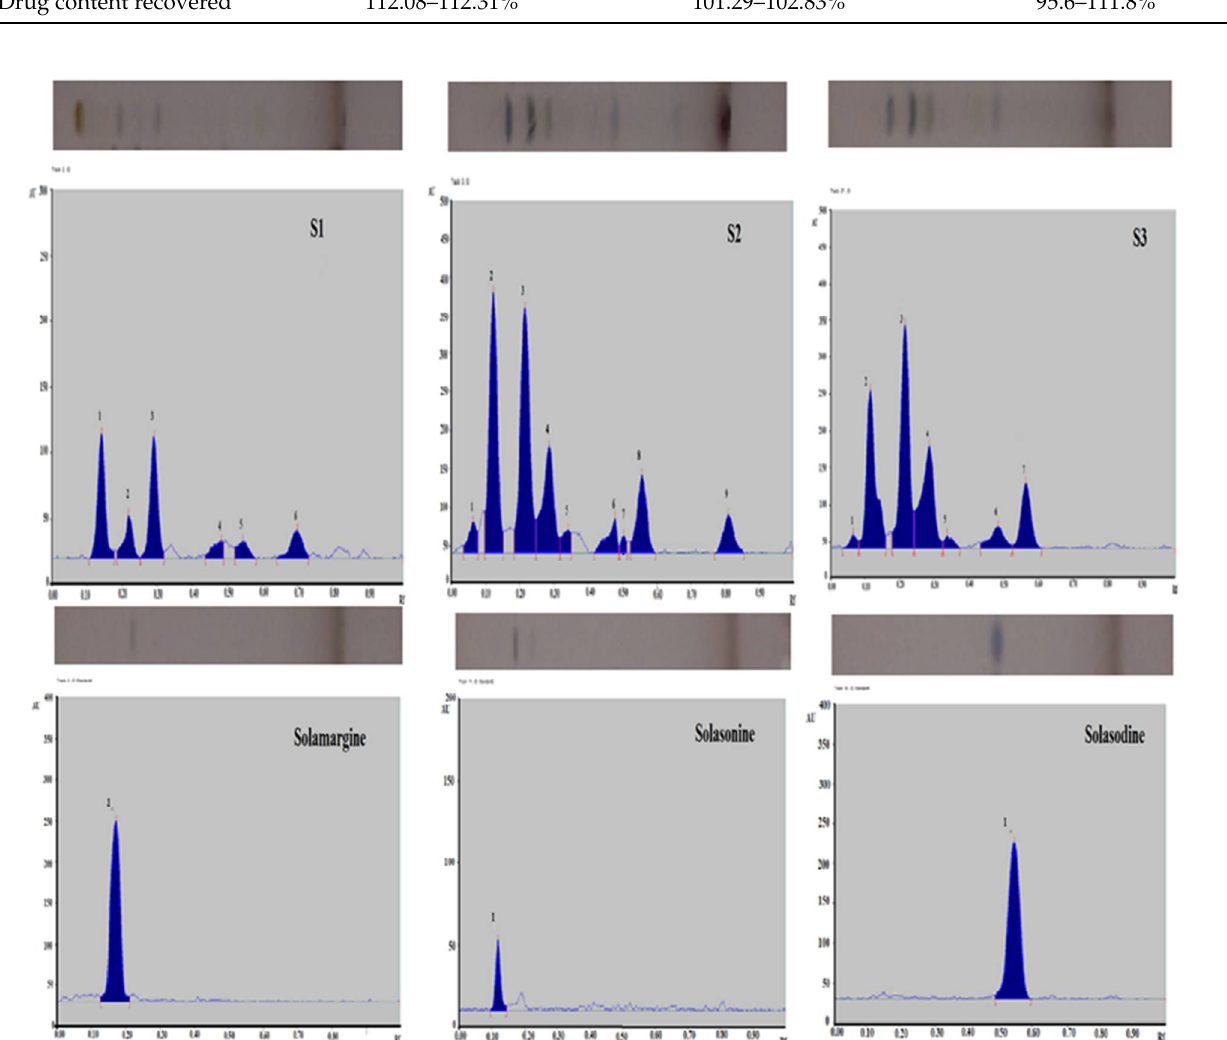
Figure 6. TLC photographic representation and quantitative estimation of biomarkers Solamargine, Solasonine Solasodine in Solanum xanthocarpum Schrad. & Wendl. aqueous (S1), ethanolic (S2) and hydro-ethanolic (S3) extracts respectively at 540 nm post derivatization using butanol: ethyl acetate: 10% acetic acid (5:3.5:1.5). Table 2. Quantification and validation of Solamargine, Solasonine, Solasodine in different extracts of Solanum xanthocarpum Schrad. & Wendl.